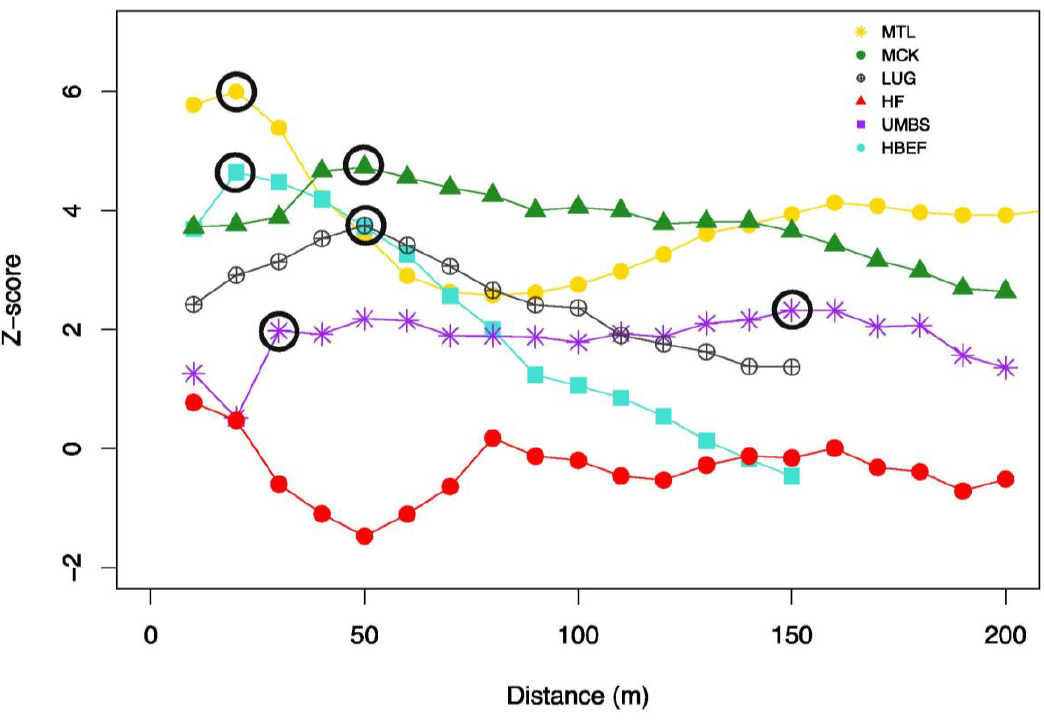
Figure 4. Peak spatial autocorrelation of canopy rugosity along transects from six forested landscapes in eastern USA. The peak z -score from Incremental Autocorrelation analysis indicates the distance at which spatial clustering of canopy rugosity is greatest along a transect. Circled symbols indicate a statistically significant peak z -score for a forested landscape. N Transects = 3 per forested landscape.